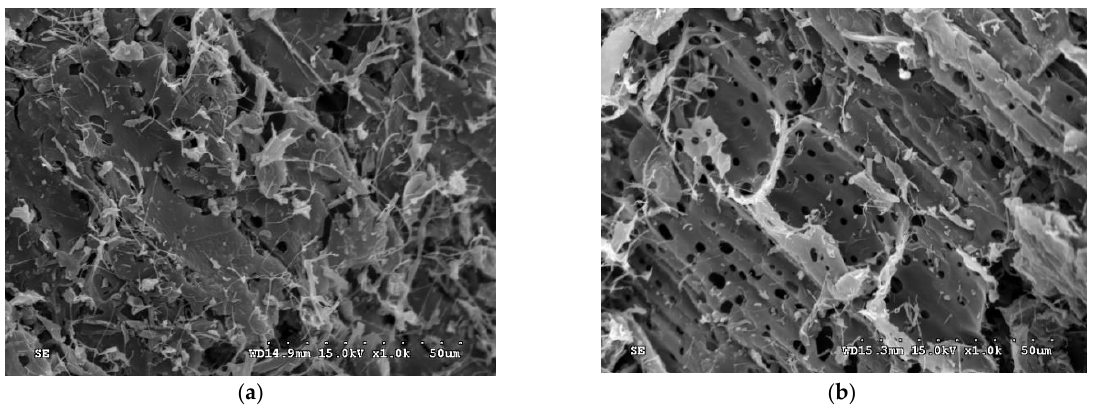
Figure 6. SEM images (×1000, right) of the biochar products for ( a ) SMC-BF and ( b ) SMC-BF-BC-800.